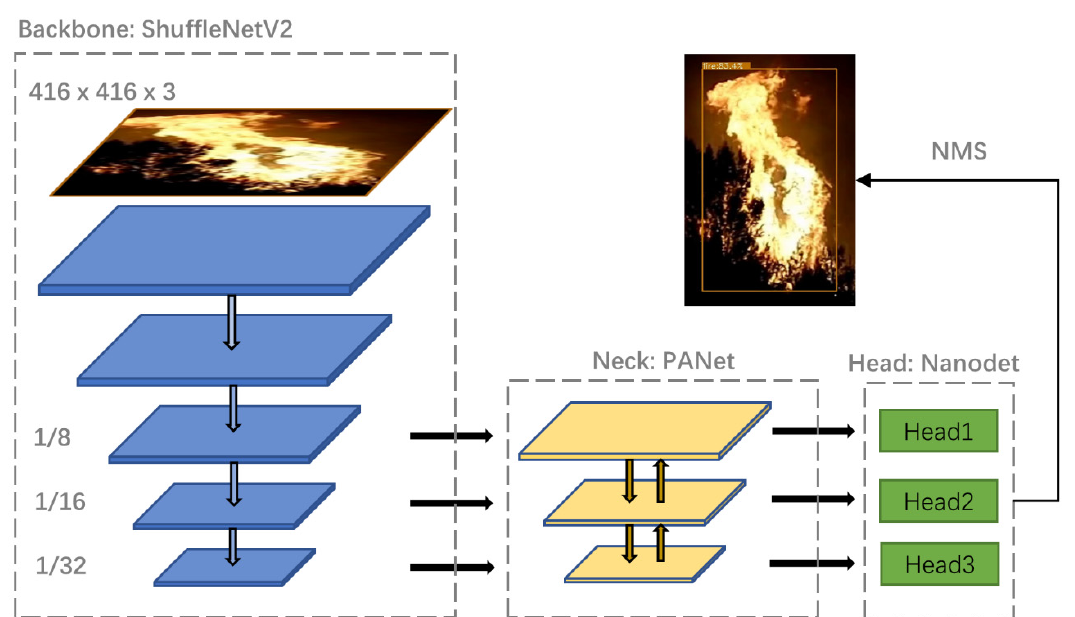
Figure 5. Overview of the network architecture. It consists of three main parts: (1) Backbone: ShuffleNetV2, (2) Neck: PANet, and (3) Head: NanoDet head. The backbone, neck, and head are for feature extraction, feature fusion, and classification and regression, respectively.